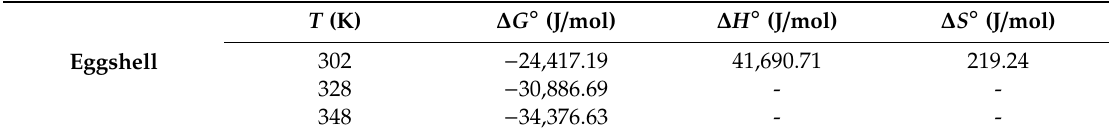
Figure 6. Van’t Hoff plot for the adsorption of Direct Blue 78 onto eggshell at different temperatures. Table 3. Thermodynamic parameters for the adsorption of Direct Blue 78 onto eggshell at different temperatures.